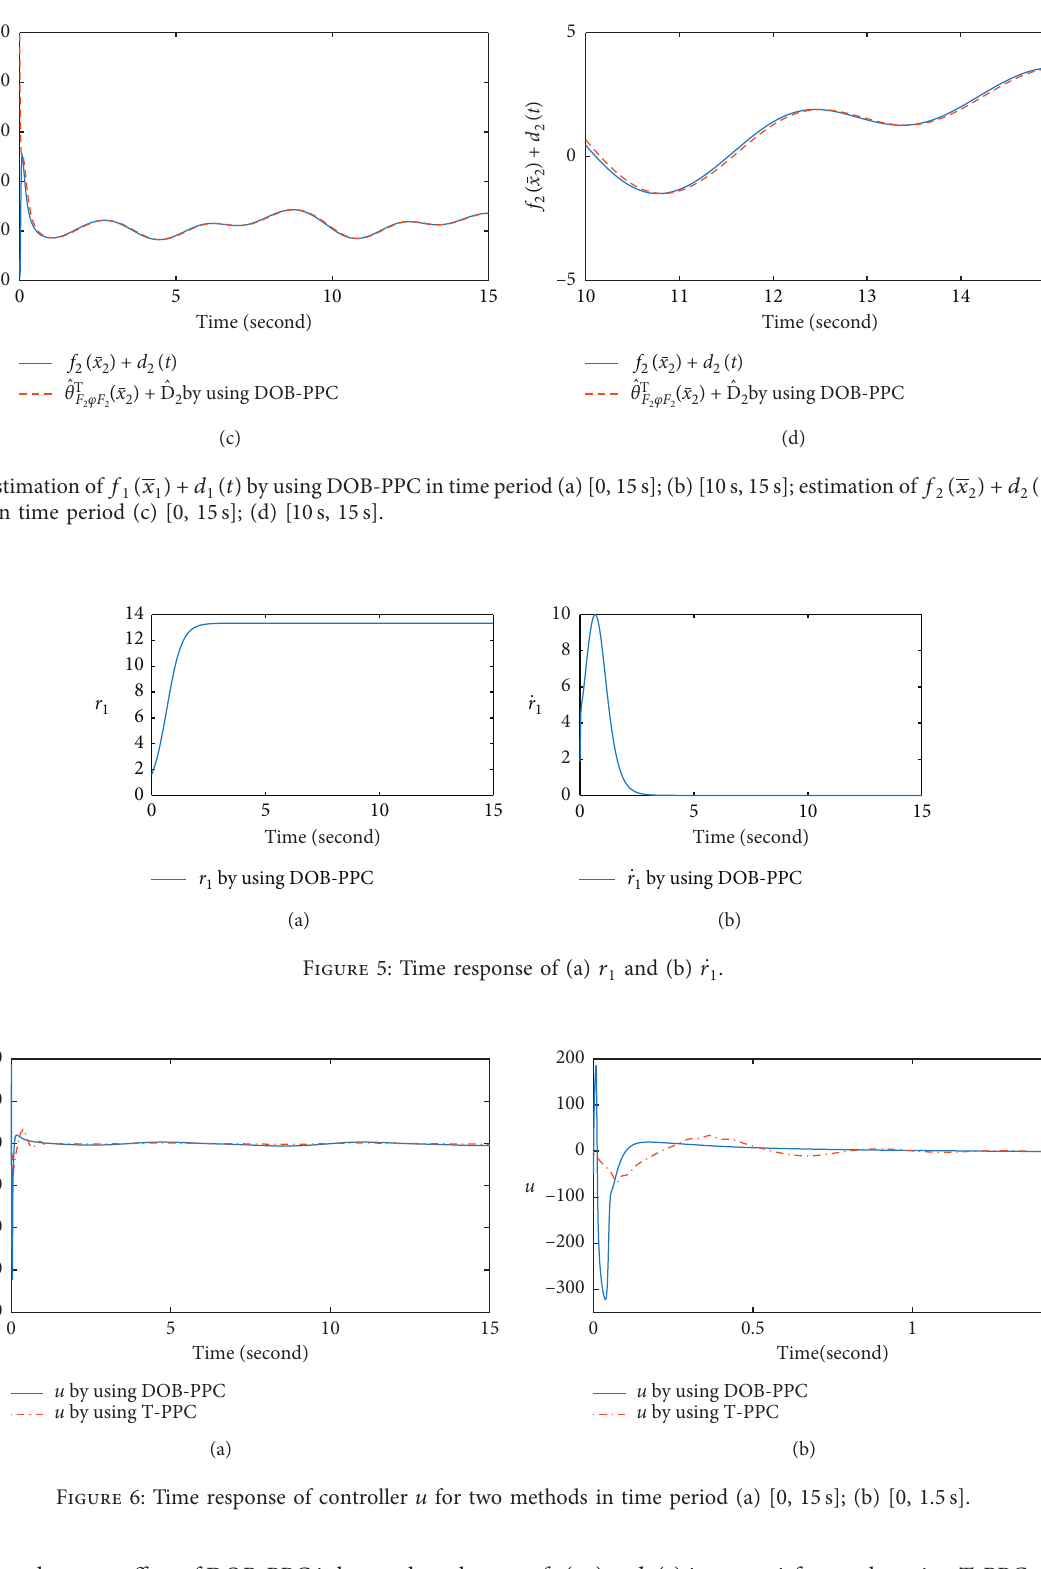
Figure 6: Time response of controller u for two methods in time period (a) [0, 15s]; (b) [0,